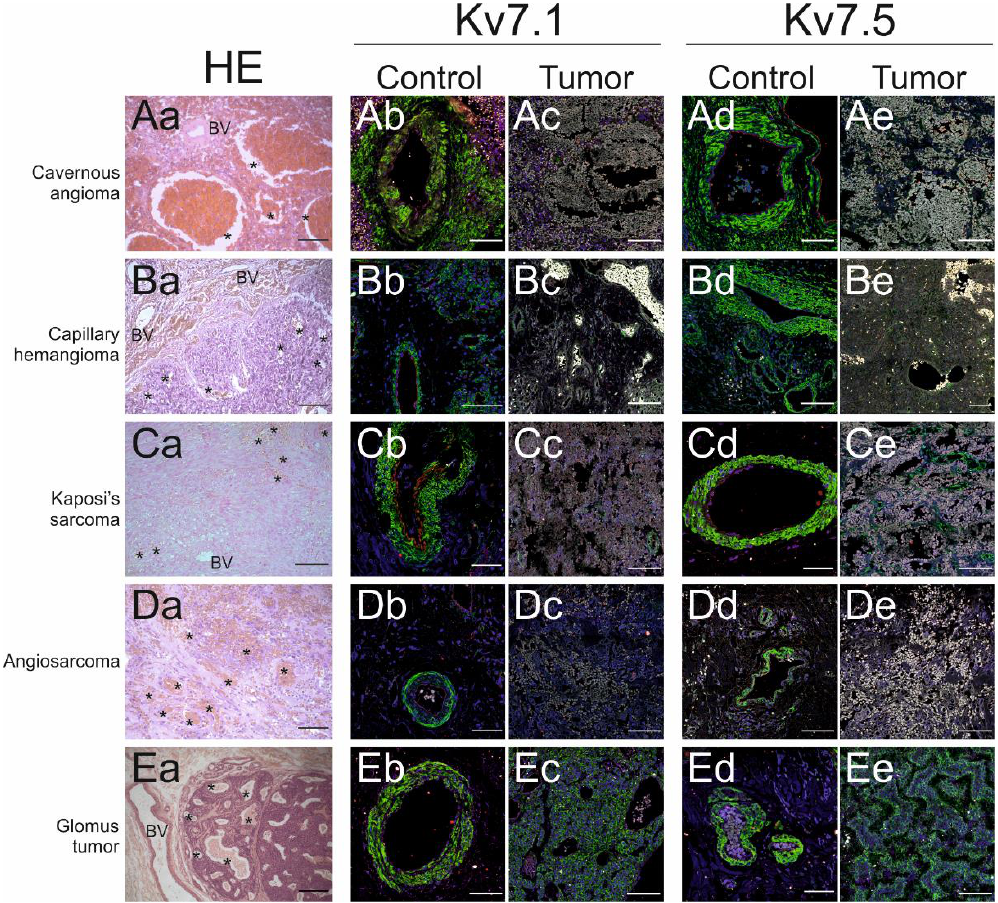
Figure 2. Kv7.1 and Kv7.5 expression in paraffin-embedded vascular tumors. Consecutive sections of vascular tumor samples were stained with hematoxylin-eosin (HE) and were immunofluorescently labeled for Kv7.1 and Kv7.5. ( Aa – Ae ) Cavernous angioma. ( Ba – Be ) Capillary hemangioma. ( Ca – Ce ) Kaposi’s sarcoma. ( Da – De ) Angiosarcoma. ( Ea – Ee ) Glomus tumor. HE was used to identify structures. BV: healthy blood vessels; *: tumoral blood vessels. Scale bars: 50 μm, capillary angioma; 100 μm, cavernous angioma, Kaposi’s sarcoma and angiosarcoma; 200 μm, glomus tumor. Representative immunolabeling images showing merged Kv7.1 in healthy ( Ab , Bb , Cb , Db , Eb ) and tumor ( Ac , Bc , Cc , Dc , Ec ) biopsies. Representative immunolabeling images showing merged Kv7.5 in healthy (Ad, Bd, Cd, Dd, Ed) and tumor ( Ae , Be , Ce , De , Ee ) biopsies. Red, channels; green, α-actin (muscle); blue, DAPI nuclear staining; gray, far red detection of red blood cells showing high autofluorescence Scale bars: 100 μm in cavernous and capillary angioma; 80 μm in Kaposi’s sarcoma, angiosarcoma and glomus tumor.